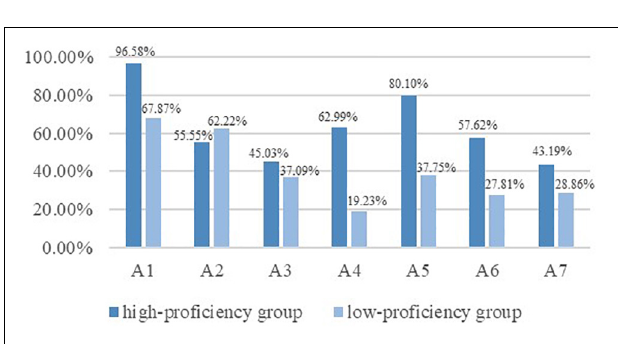
FIGURE 4 | Attribute prevalence of high and low proficiency